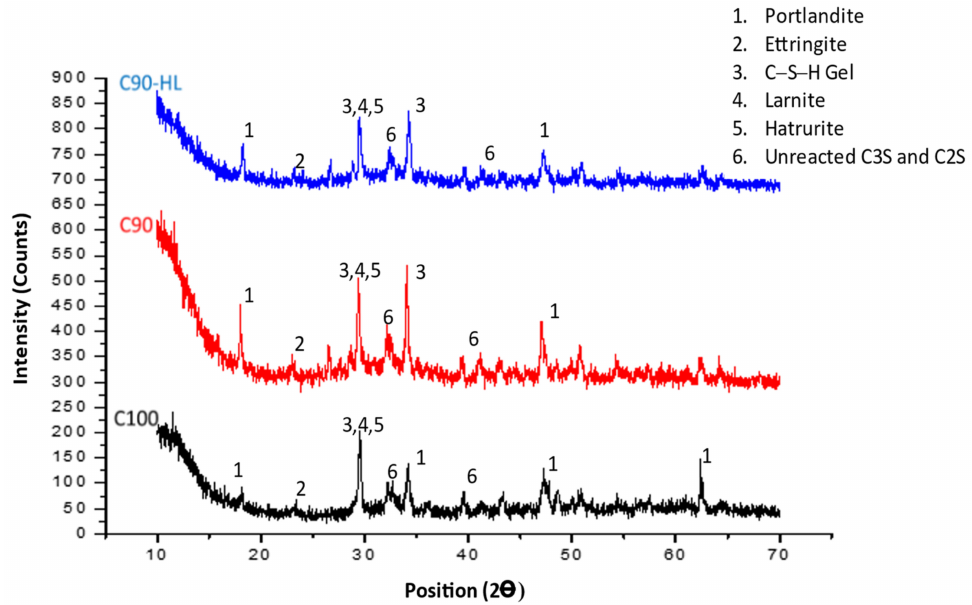
Figure 18. X-ray diffraction of self-compacting paste formulations at 28